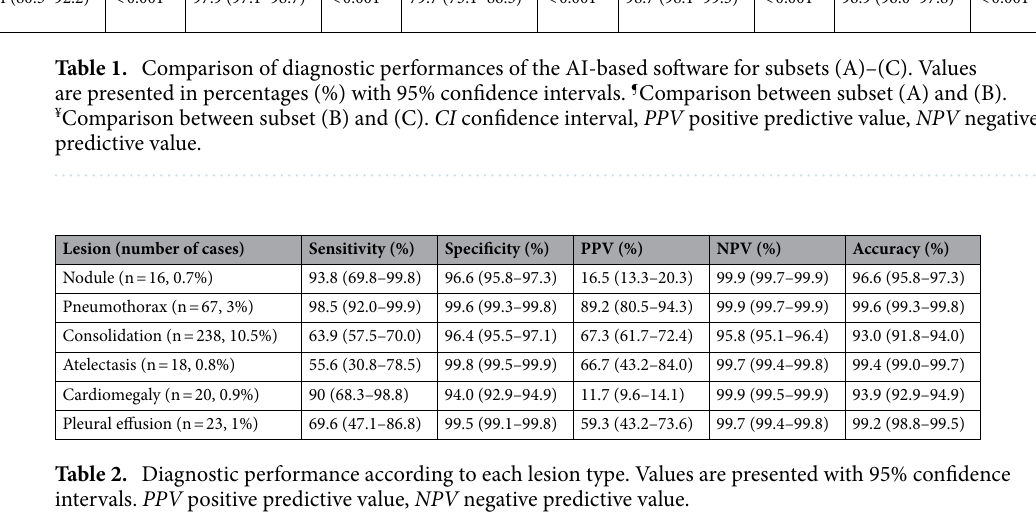
Table 2. Diagnostic performance according to each lesion type. Values are presented with 95% confidence intervals. PPV positive predictive value, NPV negative predictive value.